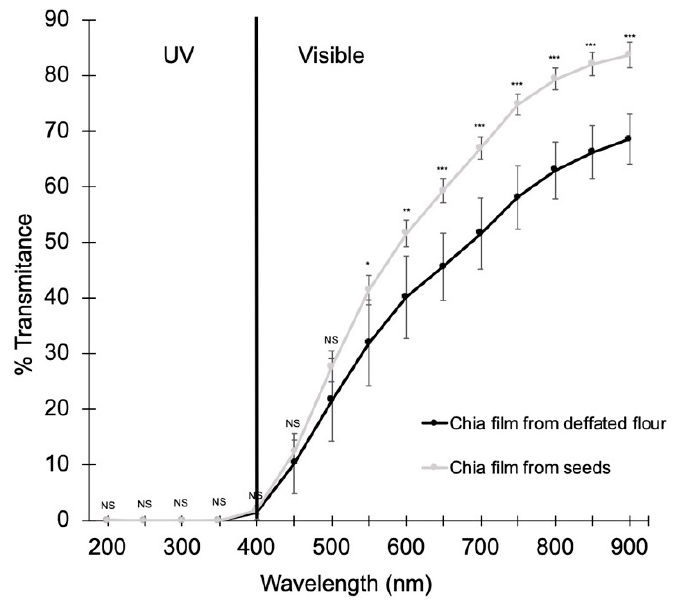
Figure 1. Light transmittance capacity of the films made with whole seeds and defatted flour. Significance differences are indicated as follows: NS: Not significant, * p < 0.05, ** p < 0.01, *** p < 0.001.